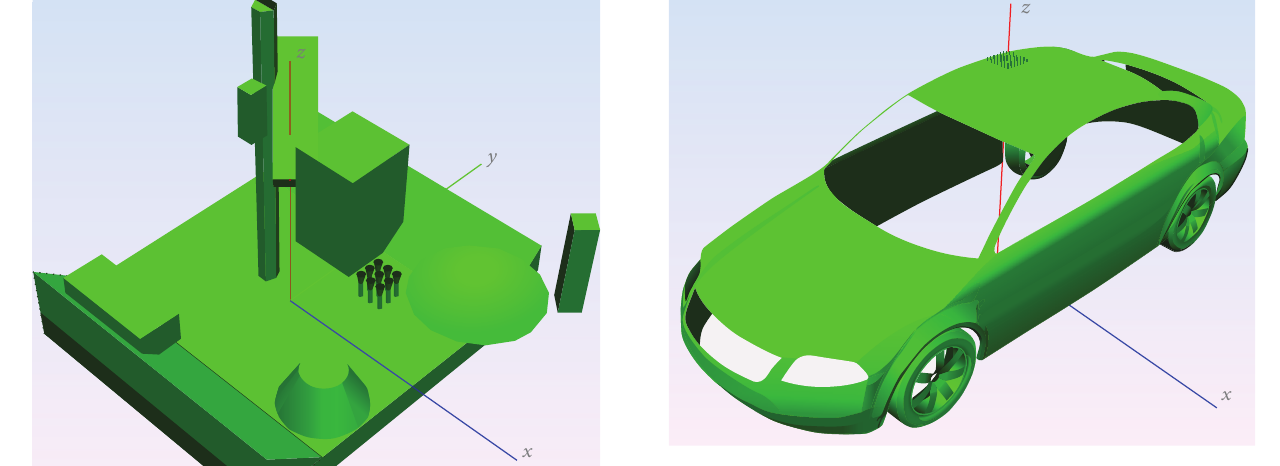
Figure 5: Geometrical model of the Passat with an array of 7 × 7 vertical dipoles.